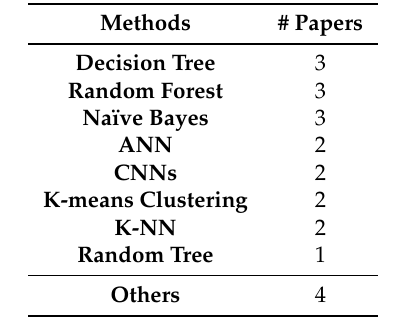
Table 4. Number of papers detailing methods for data collection and analysis. Methods